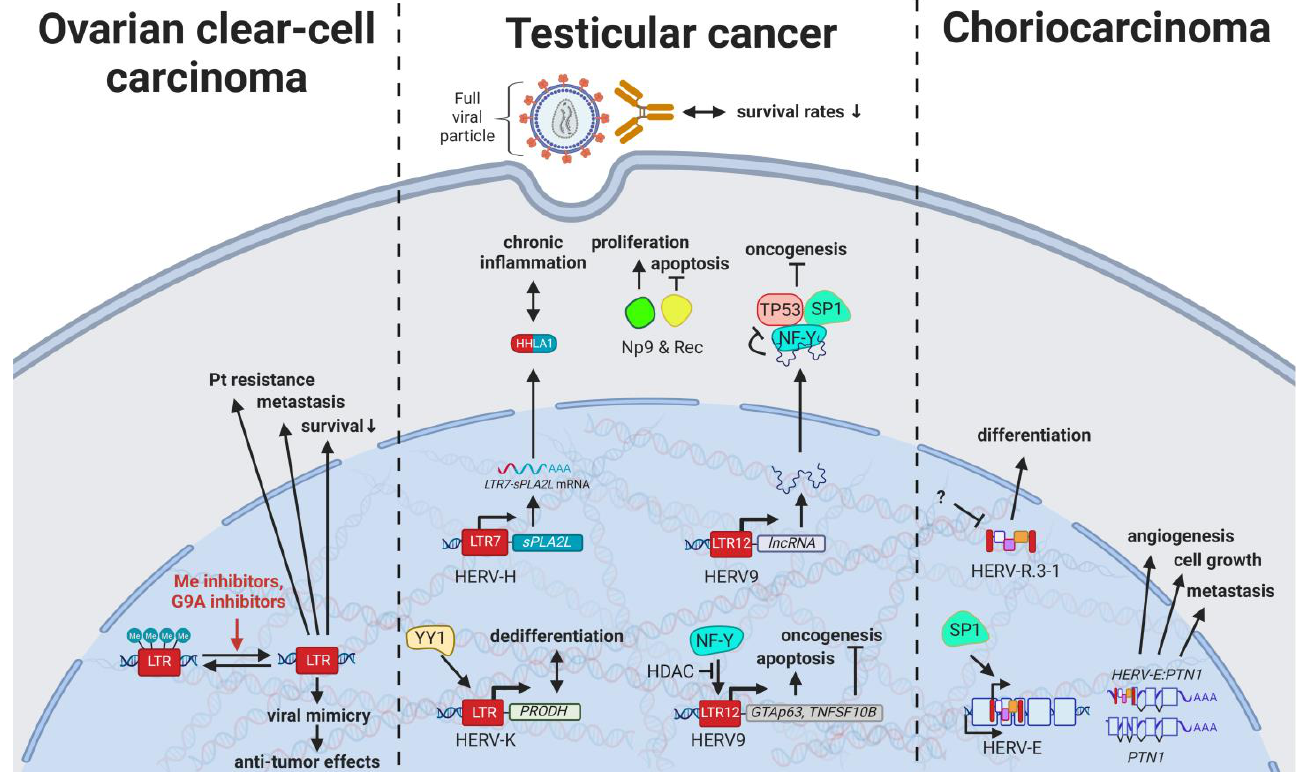
Figure 5. The role of HERVs in genital cancers. Evaluated treatments are marked in red. Abbrevia- tions: HDAC = histone deacetylases, Me = methylases, G9A = G9a methyltransferase, Pt = platinum treatment, HERV-K = HML-2.